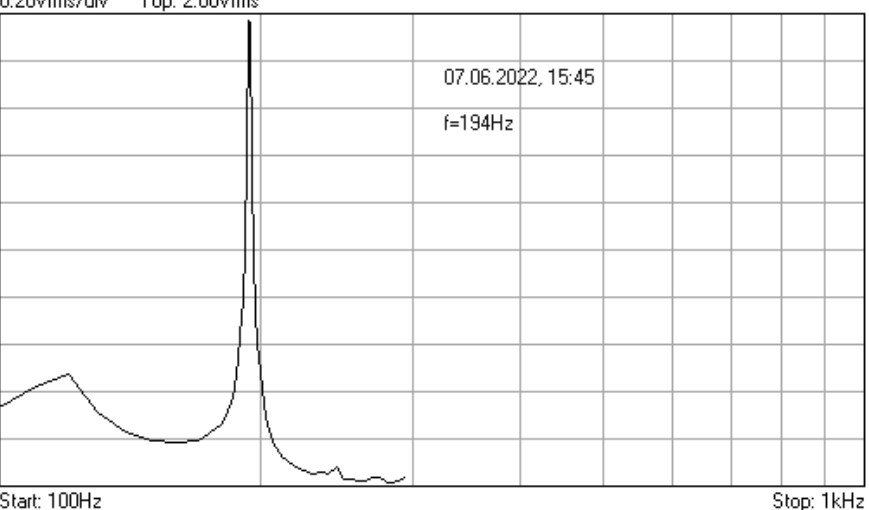
Figure 7. Frequency response function recorded after 843,696 cycles with frequency 195.3 Hz.